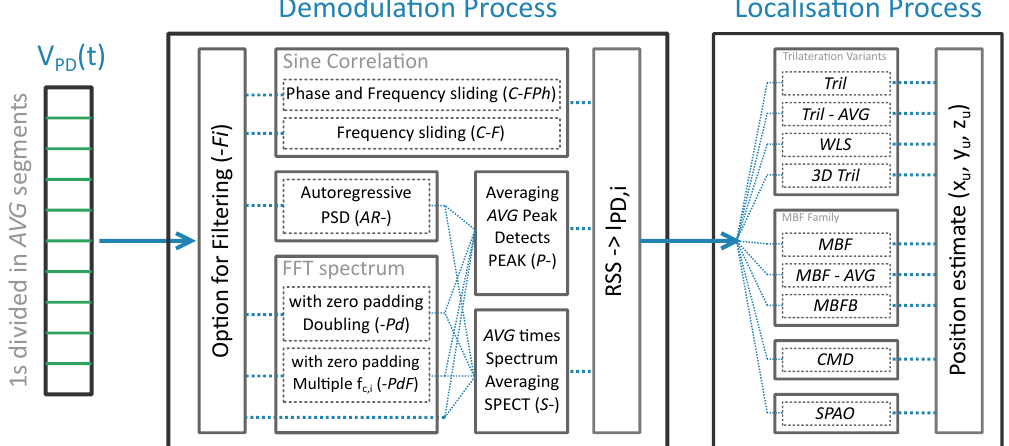
Figure 6. Flowchart representation of the (unmodulated) visible light positioning (u)VLP